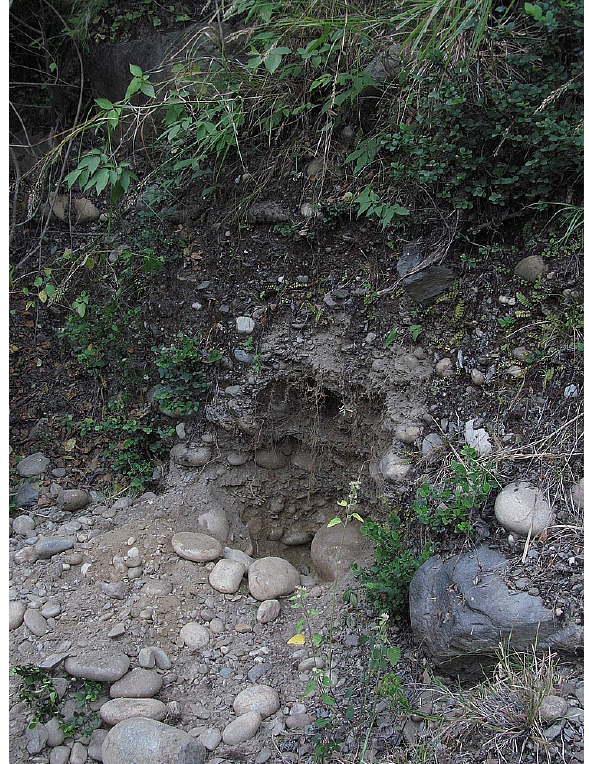
Figure A6. DVMT2 – terrace deposit ∼ 77m above modern chan- nel. Poorly sorted and weakly consolidated fluvial pebble and cob- ble conglomerate. Sample was taken from base of 6.5m unit. Unit OSL dated at 10000 ± 2000 years (Ray and Srivastava, 2010).